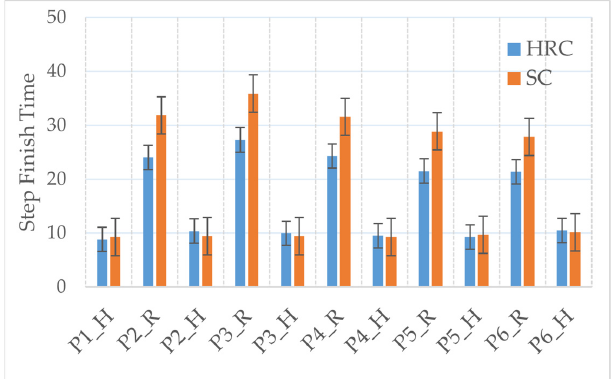
Figure 16. Step finish time comparison between human–robot collaboration with early prediction and speech commanded assistance.